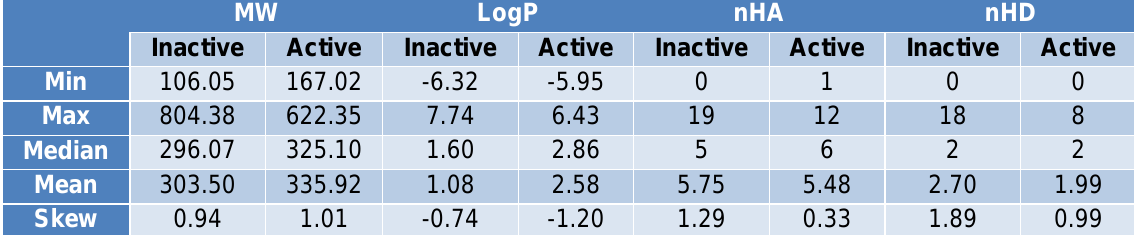
Figure 3: Distribution of Lipinski’s descriptors by bioactivities in which all the Lipinski descriptors includ- ing A) molecular weight (MW), B) lipophilicity (LogP), C) number of hydrogen bond acceptor atom (nHA) and D ) number of hydrogen bond donor atom (nHD) are calculated and compared between inactive and active classes. Table 3: Lipinski descriptor statistics of inactive and active classes